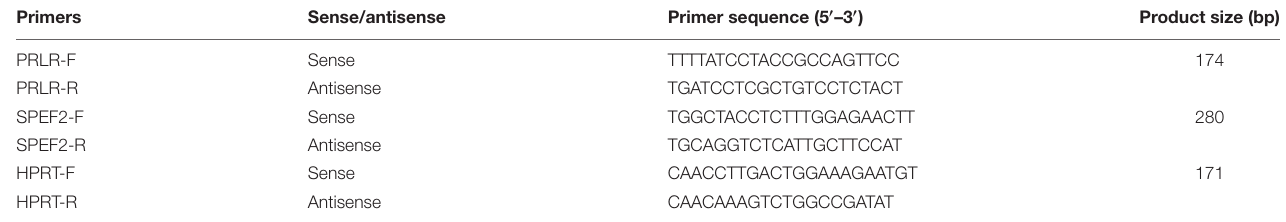
TABLE 1 | The primer sequences for quantitative real-time PCR. Primers